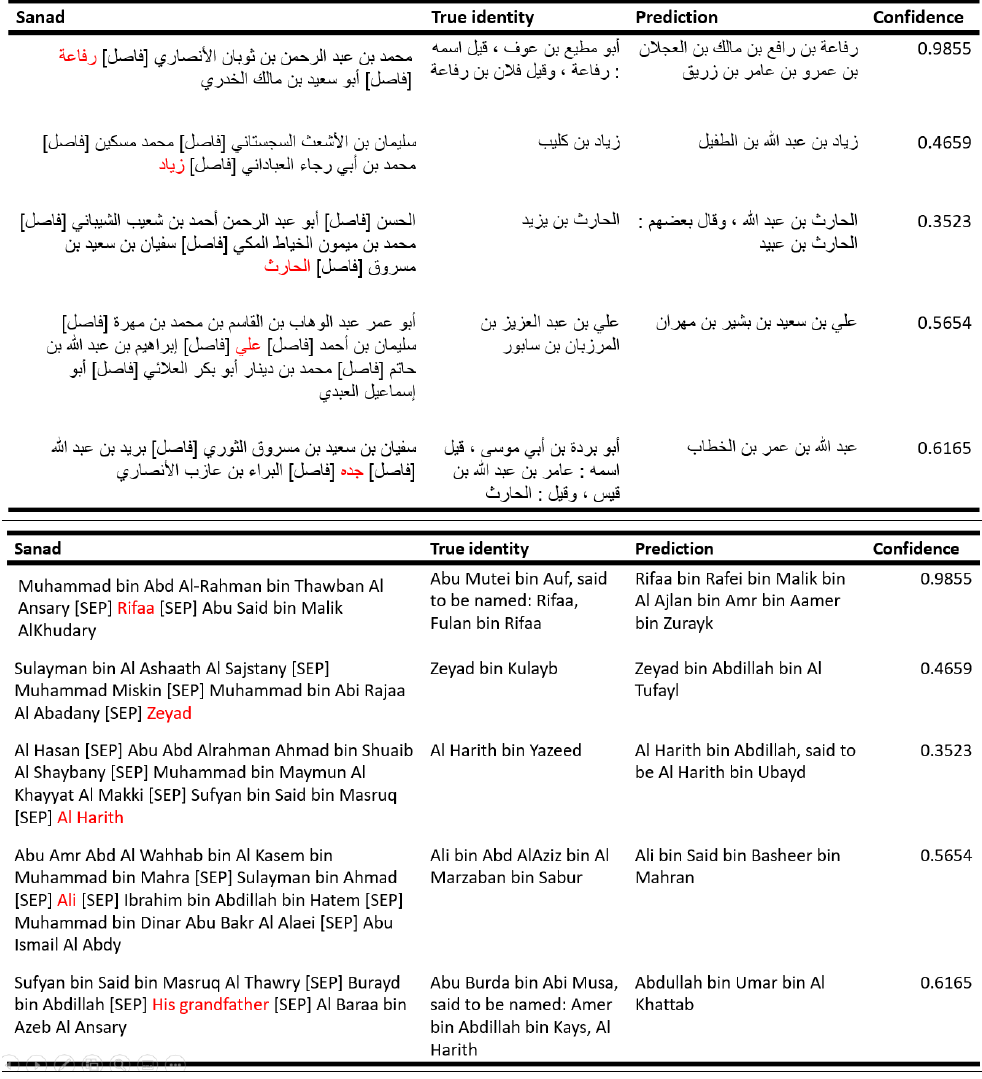
Figure 8. Examples of false predictions for narrators marked in red, their true identity, the false identity predicted by the model and the model’s confidence in the